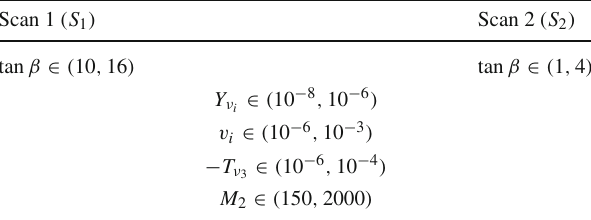
Table 2 Range of low-energy values of the input parameters that are varied in the two scans, where Y ν tan β is a flat prior. The VEVs v i , and the soft parameters T ν are given in GeV